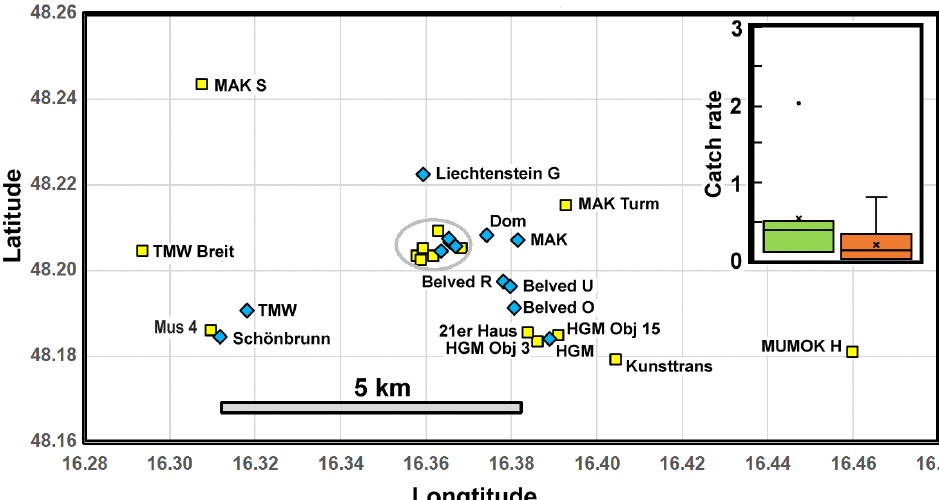
Figure 5. Coordinates of Viennese museums with high catch rates >0.02 for Ctenolepisma calvum (blue diamonds) and low catch rates (yellow squares) over the 5 years 2017–2021. Note: The gray ellipse encloses Hofburg, Leopold, Liechtenstein S, Mus 1–3, Mus 5, MUMOK, and NHM, with abbreviations listed in Supplement Table S1 Inset: Box-and-whisker plots of catch rates at the popular museums (green) and less visited sites (red). Note: The quartiles Q 1 and Q 3 define the box, the horizontal line defines the median, the cross defines the mean, whiskers define points within 1.5 times the interquartile range, and isolated points are outliers.